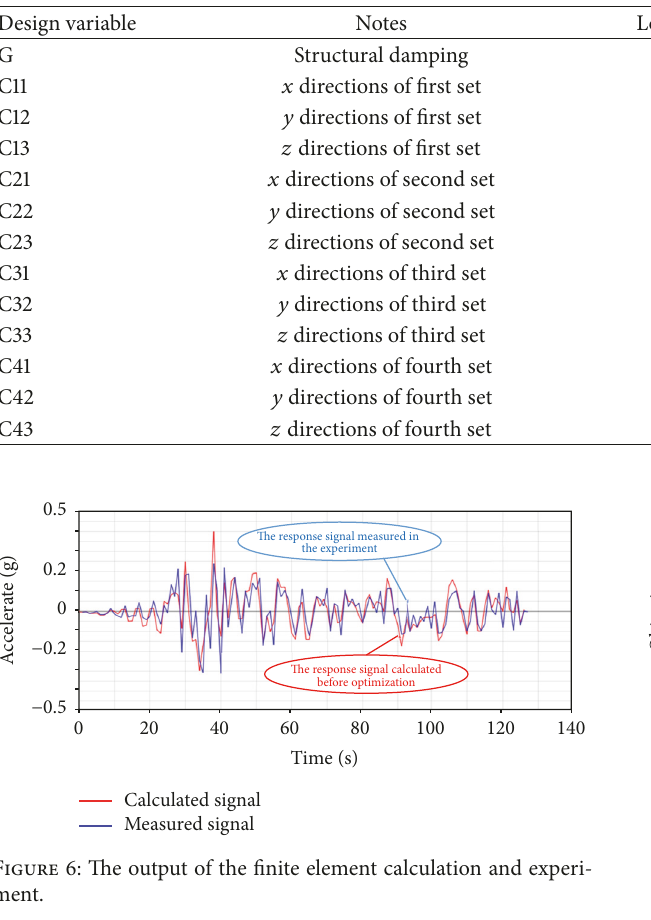
Table 4: The data sheet of design variable (Ns/m).